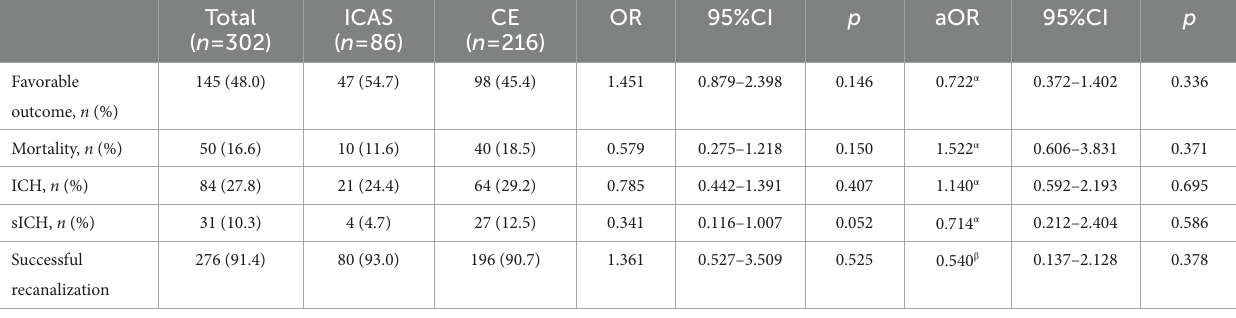
TABLE 3 Univariable analysis and multivariable analysis of functional outcomes.